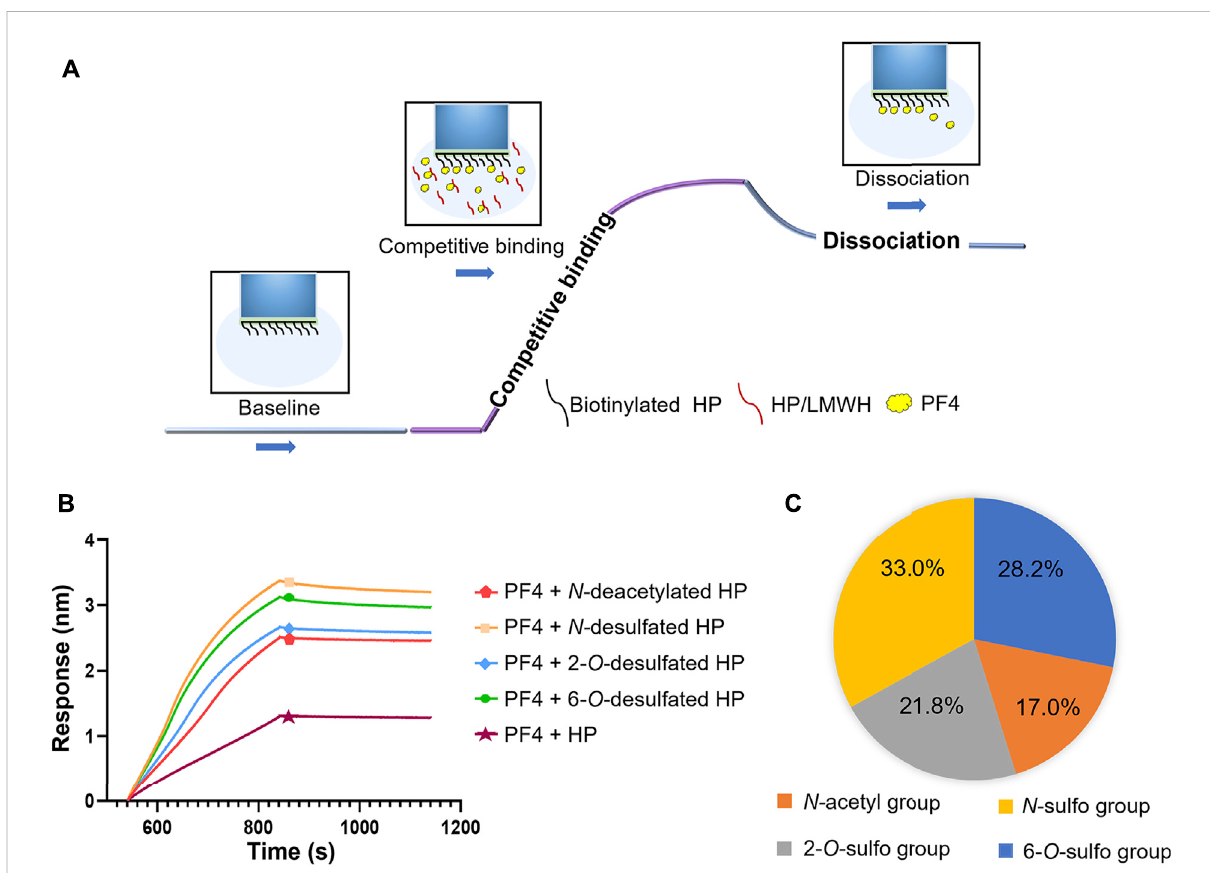
Effects of different HP substitutions on the PF4-HP interaction. (A) The diagram of competitive BLI method. (B) Competitive binding sensorgrams of HP and HP derivatives ( N -deacetylated HP, N -desulfated HP, 2- O -desulfated HP, and 6- O -desulfated HP). (C) The contribution percentage of each substitution type to HP binding to